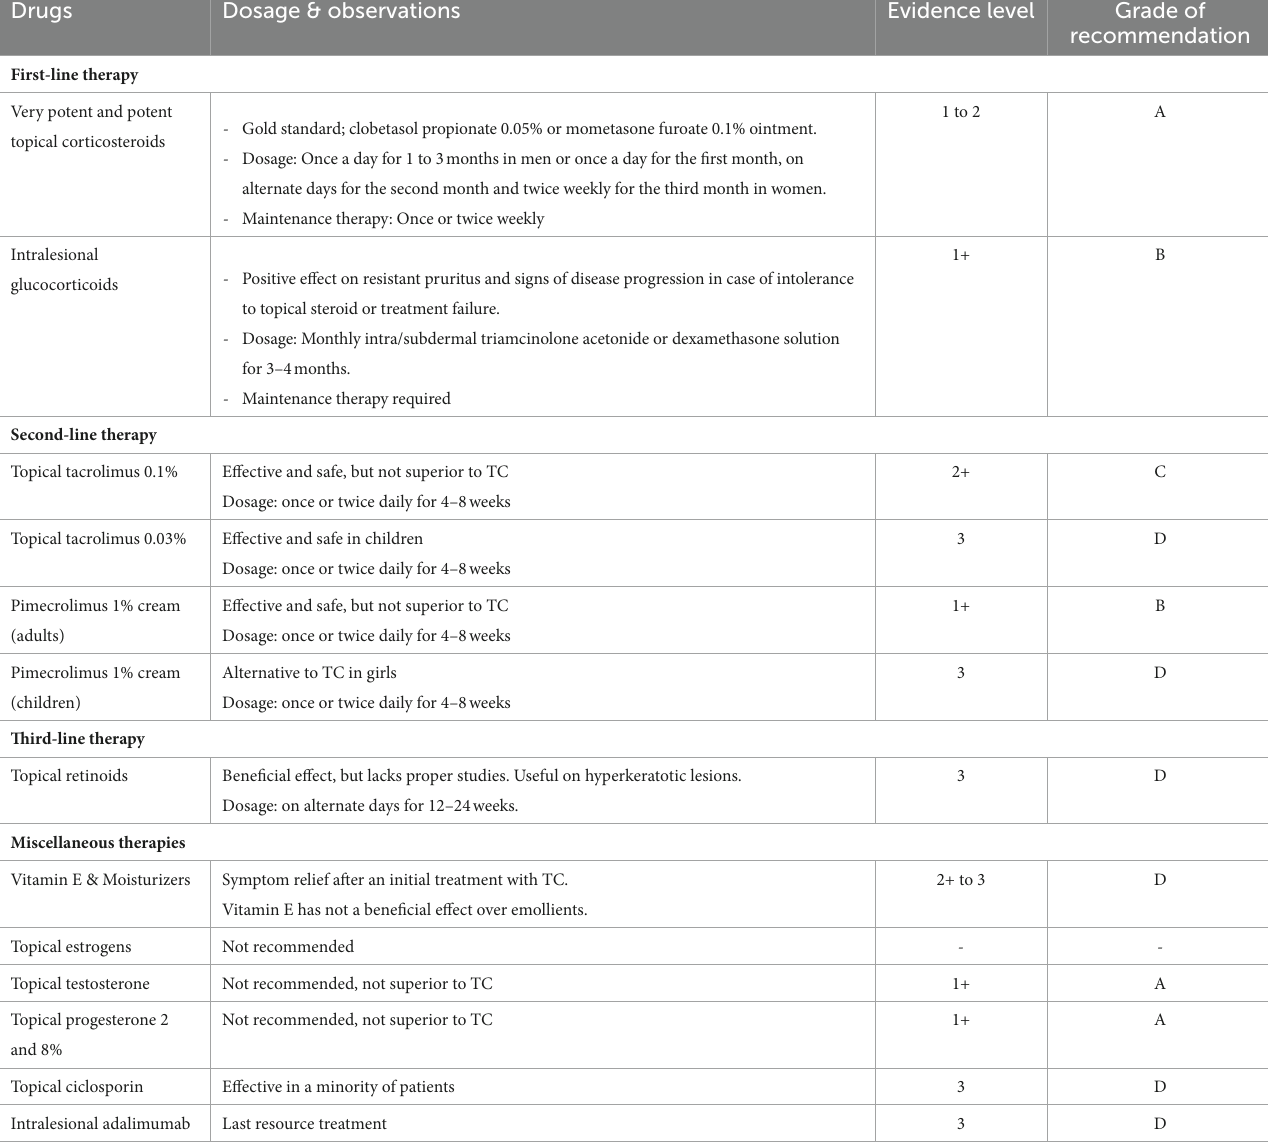
TABLE 8 Summary of topical and intralesional therapies in lichen sclerosus (3, 9, 77). Drugs Dosage &